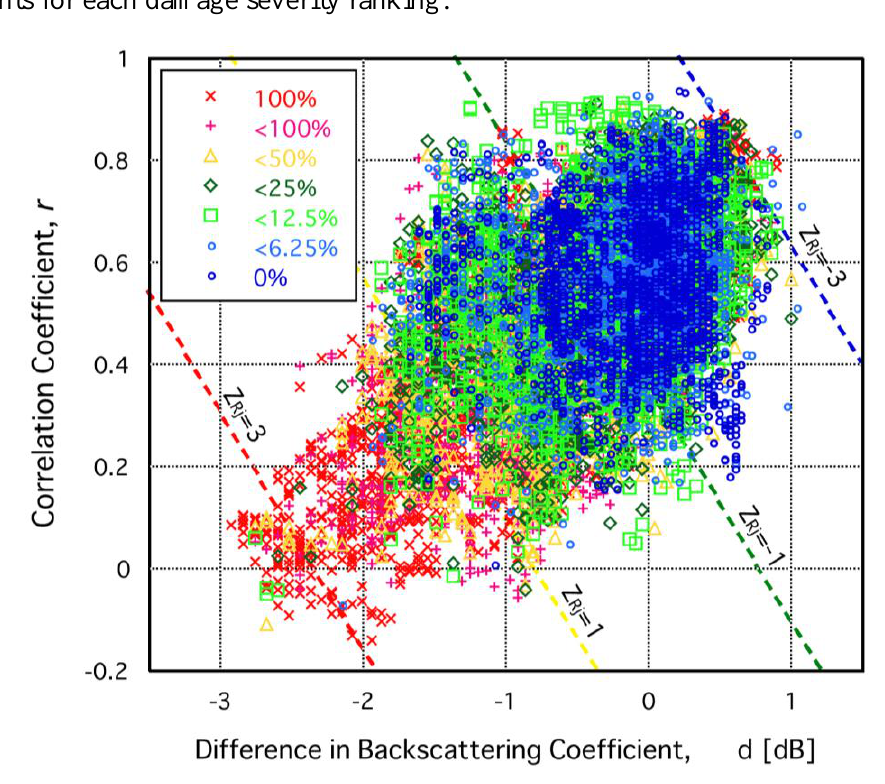
Figure 2. Scatter diagram of the difference in backscattering coefficients and correlation coefficients for each damage severity